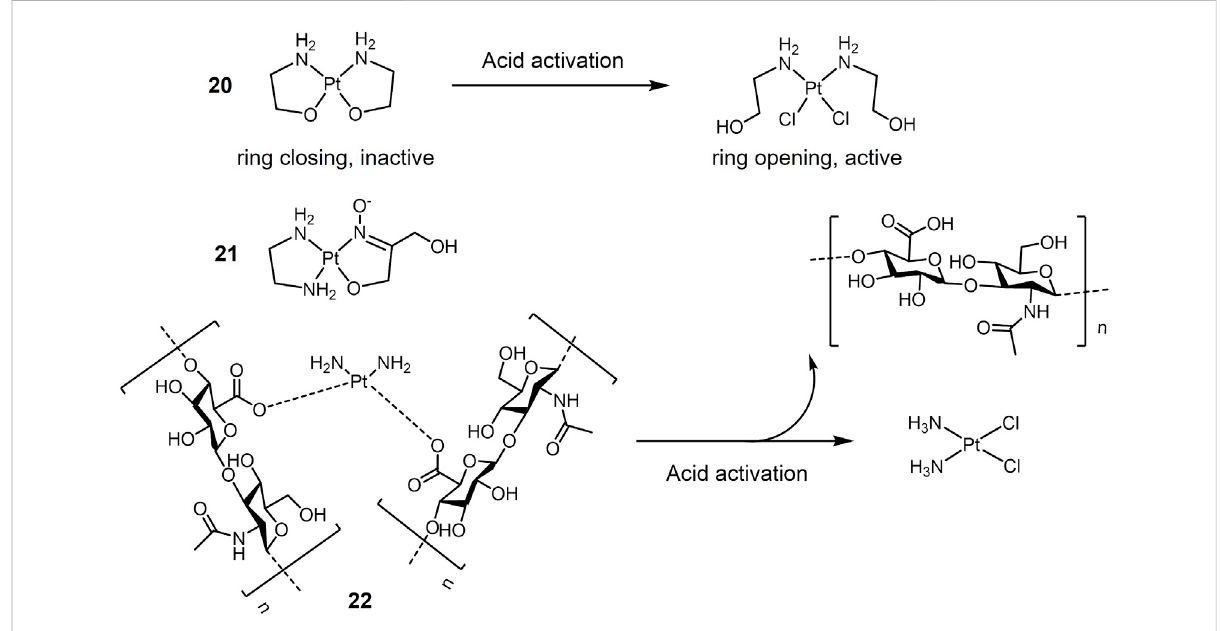
FIGURE 4 pH-responsive Pt(II) complexes undergoing acid